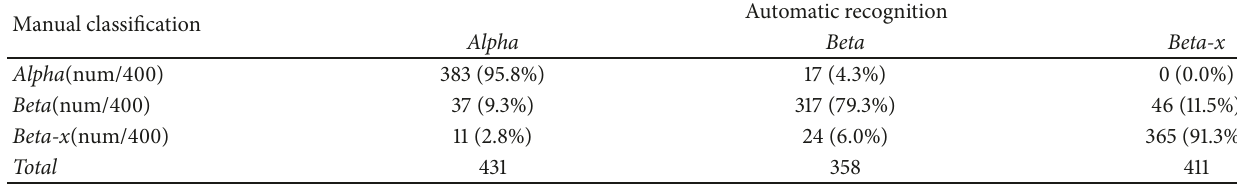
Table 7: Details of Model C Classification